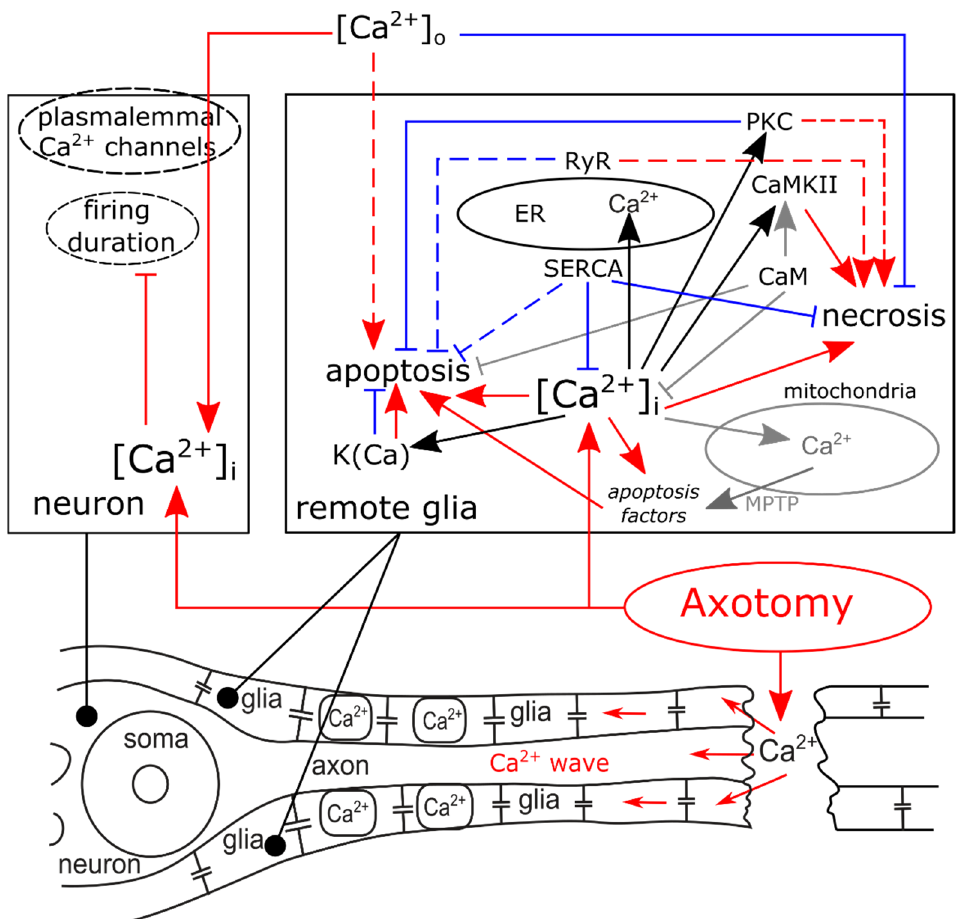
Figure 2. Involvement of Ca 2+ ions, Ca 2+ channels, and Ca 2+ -dependent proteins in death or survival of remote glial cells (RGC) in crayfish stretch receptors after axotomy (AT), based on our experimental data. AT induces Ca 2+ influx into axolemma and the elevation of Ca 2+ levels in cytosol of neuron and glia ([Ca 2+ ] i ), promoting the cessation of neuron firing and glial death. The work of SERCA, pumping Ca 2+ from cytosol, protects remote glial cell from necrosis and apoptosis. Protein kinase C (PKC) and calmodulin kinase II (CaMKII) are involved in the necrosis of RGC, but PKC decreases their apoptosis, as well as Ca 2+ -dependent potassium channels K(Ca). Extracellular Ca 2+ ([Ca 2+ ] o ), promotes apoptosis, but decreases the necrosis of RGC. Sharp arrowheads: increase effects. Blunt arrowheads: decrease effects. Dashed lines: the effect takes place only after AT. Red: detrimental effects. Blue: protective effects.